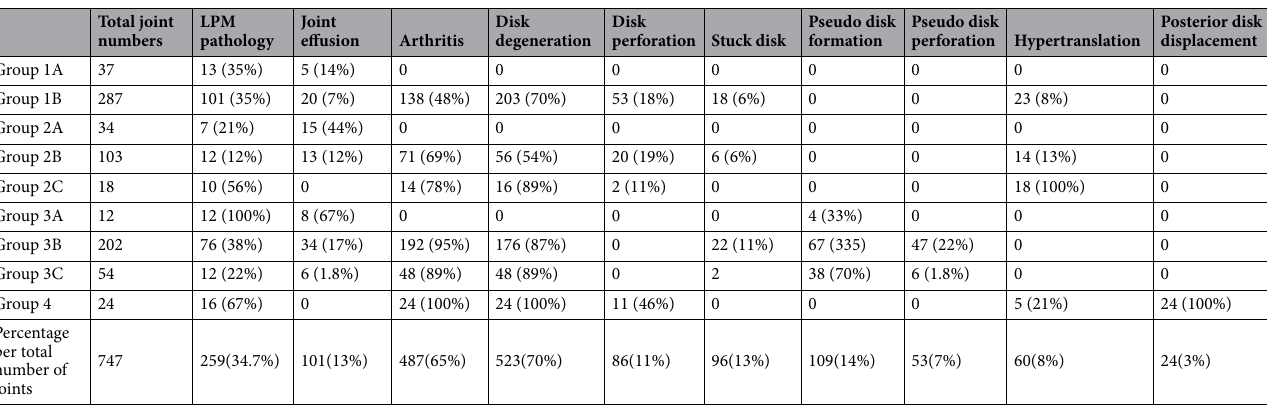
Table 3. Detailed description of the MRI finding in all of the study